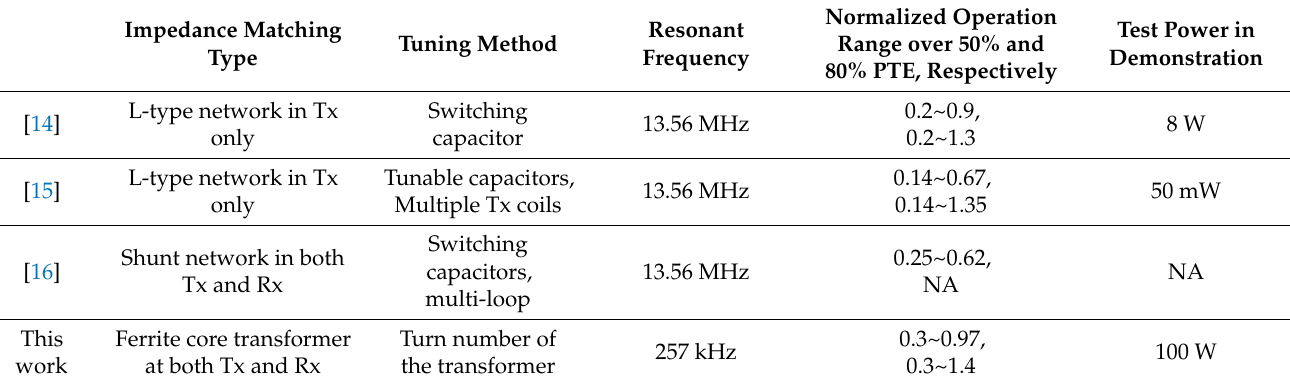
Table 4. Comparison between previous works and this